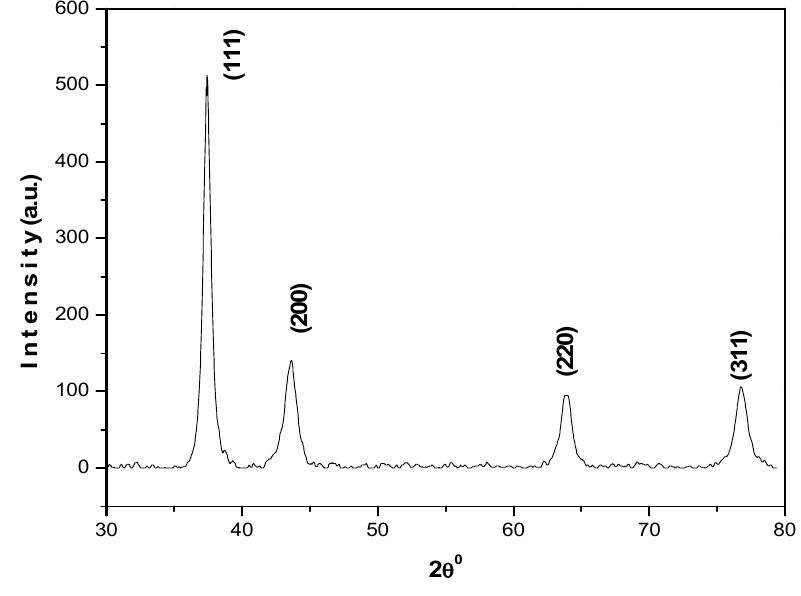
Figure 2. XRD pattern of AuNPs. The results obtained are in agreement with the JCPDS value (040784) and support the formation of a polycrystalline face-centered cubic structure of AuNPs. UV-visible absorp- tion spectra demonstrate the optical and structural characteristics of metallic nanoparticles due to the absorption bands associated with their precise diameter and aspect ratio.